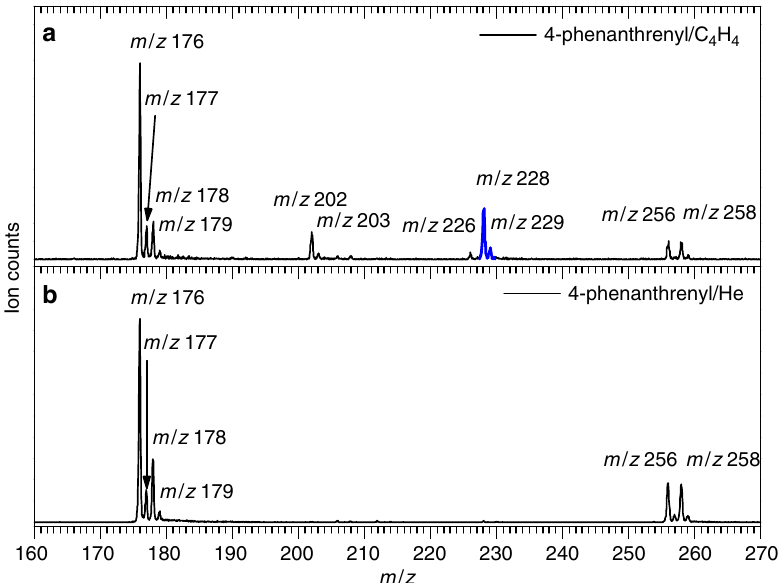
Fig. 2 Comparison of photoionization mass spectra recorded at a photoionization energy of 9.50eV. a 4-phenanthrenyl ([C 14 H 9 ] (cid:129) ) - vinylacetylene (C 4 H 4 ) system; b 4-phenanthrenyl ([C 14 H 9 ] (cid:129) ) - helium (He) system. The mass peaks of the newly formed C 18 H 12 ( m/z = 228) species along with the 13 C- substituted counterparts ( m/z = 229) are highlighted in